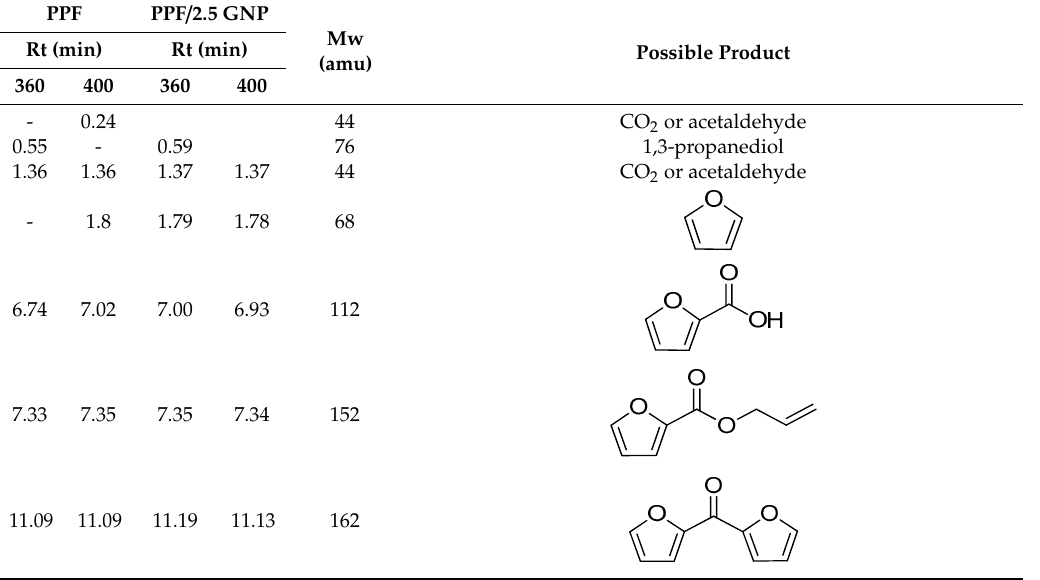
Figure 8. Total Ion Gas chromatographs of neat PPF and PPF/2.5 GNP after pyrolysis at ( a ) 360 °C; ( b ) 400 °C. The highlighted peaks correspond to compounds that are evolved via secondary degradation routes. Table 3. Possible pyrolysis products of neat PPF and PPF/2.5 GNP nanocomposite.